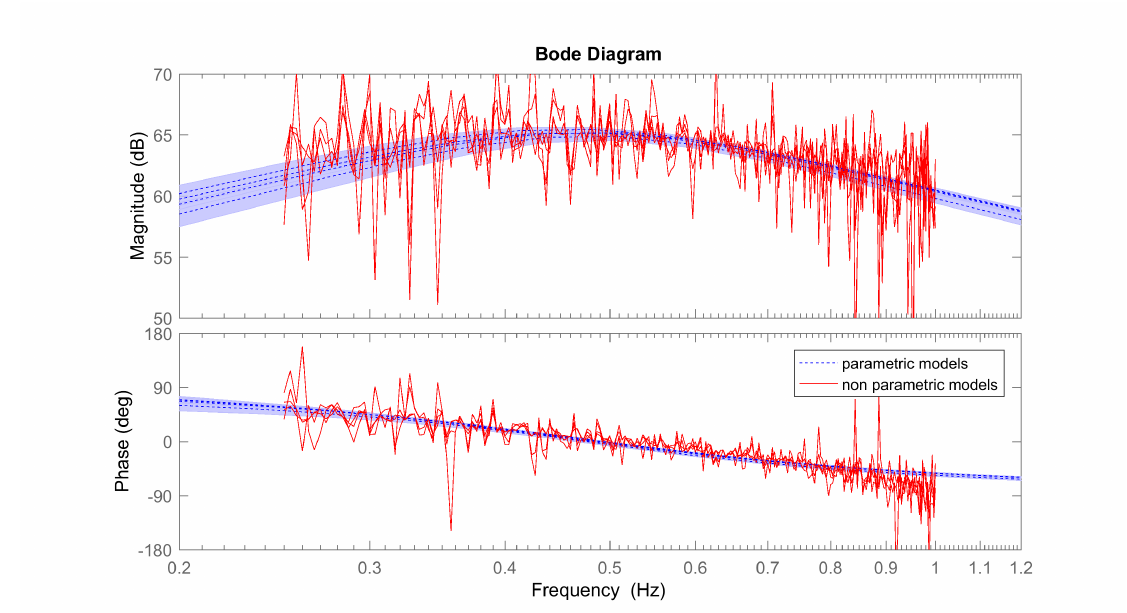
Figure 22. Comparison of Bode plots and FRFs of ˜ Z r obtained from different experiments (experiments: 081, 082, 086, 087 and 089). The 95% confidence interval is the shaded area around the magnitude and phase plots of the parametric